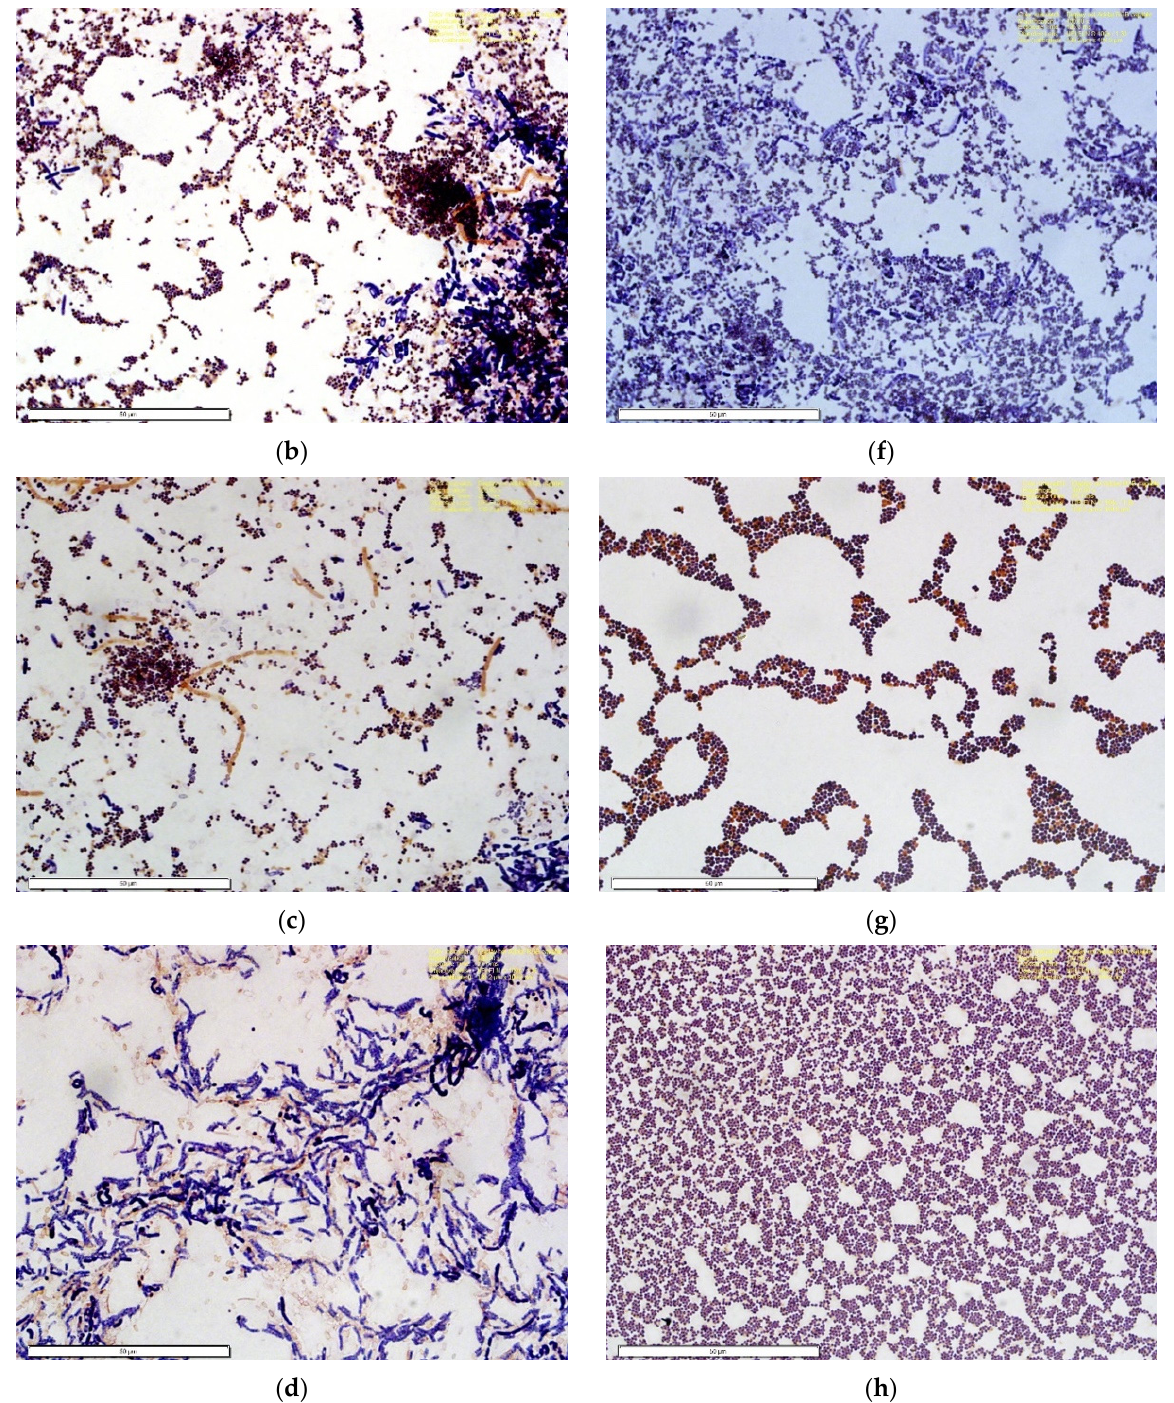
Figure 14. Illustration of Gram staining of two study groups—the control ( a – d ) (left) and PCL nanofiber mask ( e – h ) (right) used to compare the morphology and characteristics of bacteria in each group. ( a , b ) show low condensation of Gram- positive cocci and high accumulation of Gram-negative cocci, whereas ( e , f ) depict vast amounts of high Gram-positive cocci accumulation. ( c ) shows both Gram-positive and -negative cocci, bacillus, and spirochetes in lesser amounts. ( d ) shows a high amount of Gram-positive and -negative bacillus. ( g ) shows the presence of both Gram-positive and -negative cocci and ( h ) shows a high accumulation of Gram-negative cocci.